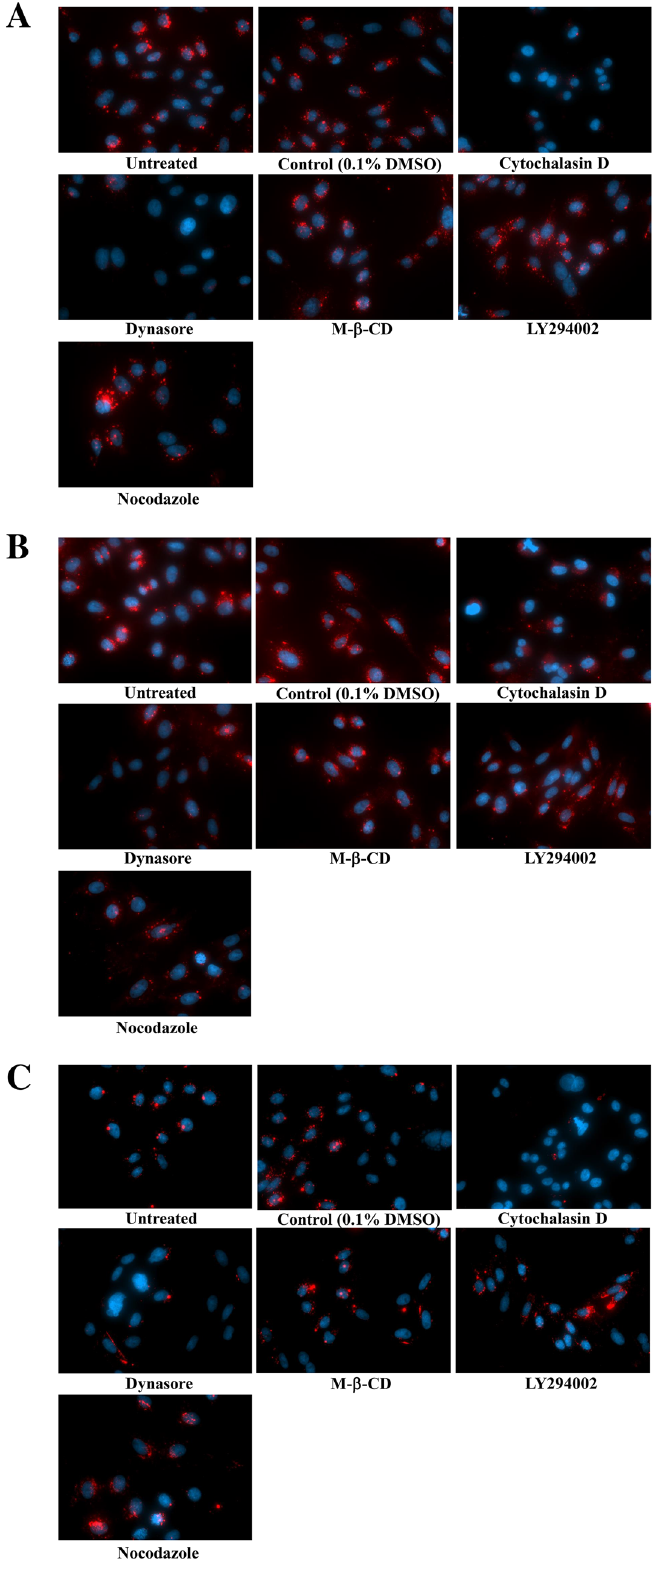
Figure 6. Effects of inhibitors on the internalization of exosomes ( A ), 20-nm ( B ), or 200-nm ( C ) particles. T-REx-CHO- MARCO cells were cultured with tetracycline in a 96-well black plate with clear bottom. The CHO-MARCO cells were pretreated with various inhibitors for 1 h, and then incubated with exosomes, 20-nm, or 200-nm particles in the presence of each inhibitor. After 6 h culture, the cells were washed twice with HBSS and fixed with 4% paraformaldehyde, followed by staining with DAPI. The cells were observed using fluorescence